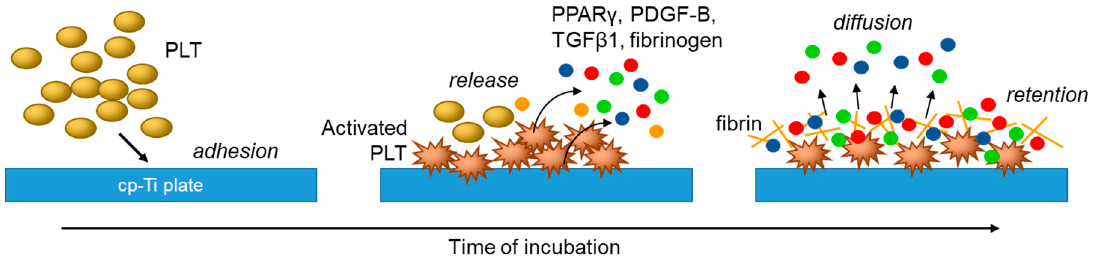
Figure 8. Proposed mechanisms of platelet adhesion and activation and subsequent growth factor release and retention on cp -Ti plates.